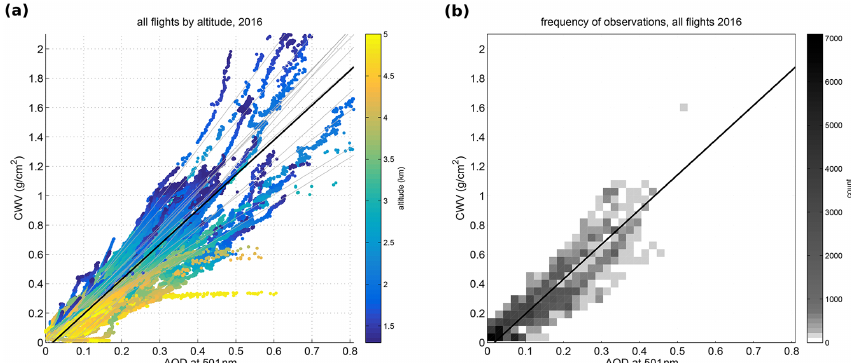
Figure 5. 4STAR AOD at 500nm versus column water vapor (CWV) for altitudes above the boundary layer to within the BB plume (1.3 to 5km) (a) by altitude for all flights and (b) as a frequency heat map over all flights. Thin grey lines show the total least-squares fits through individual flights, while the thicker black line shows the fit through all data. The correlation coefficients are fairly high for individual flights (Table 3) and only slightly lower for all flights combined ( R 2 = 0 .